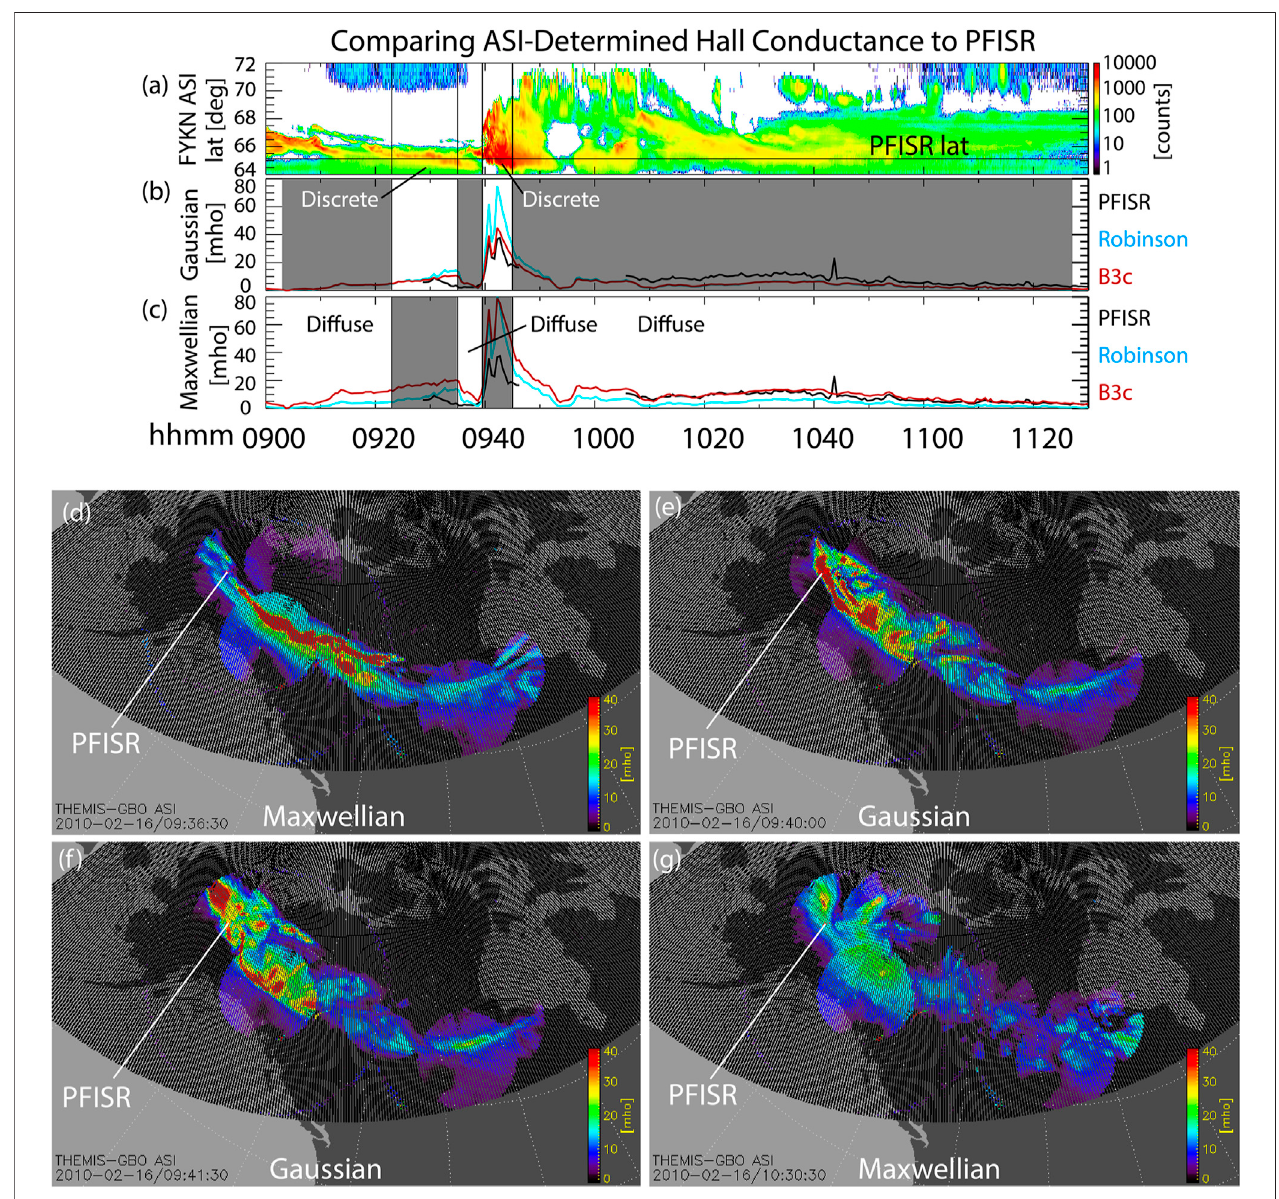
FIGURE 8 | ComparingtheASI-determinedHallconductance toPFISR-determinedHallconductance. The discreteand diffuse auroraare markedinpanelsa – c.The Gaussiandistributionwasusedtodeterminetheconductancerelatedtodiscreteaurora,andtheMaxwelliandistributionwasusedforthediffuseaurora. (A) TheFYKNwhite lightintensitykeogramatthePFISRlongitude.ThePFISRlatitudelineisdrawnhorizontally. (B) HallconductanceusingtheGaussianenergy fl uxesandaverageenergiesfrom theASIasinputtoB3C(red) andRobinson formula(blue)alongsidethePFISR-determinedresult(black). (C) HallconductanceusingtheMaxwellianenergy fl uxesand average energies from the ASI as input to B3C (red) and Robinson formula (blue) alongside the PFISR-determined result (black). (D) 2D snapshot of Hall conductance assumingaMaxwelliandistributionat09:36:30UT. (E) 2DsnapshotofHallconductanceassumingaGaussiandistributionat09:40:00. (F) 2DsnapshotofHallconductance assuming a Gaussian distribution at 09:41:30. (G) 2D snapshot of Hall conductance assuming a Maxwellian distribution at 10:30:30 UT.